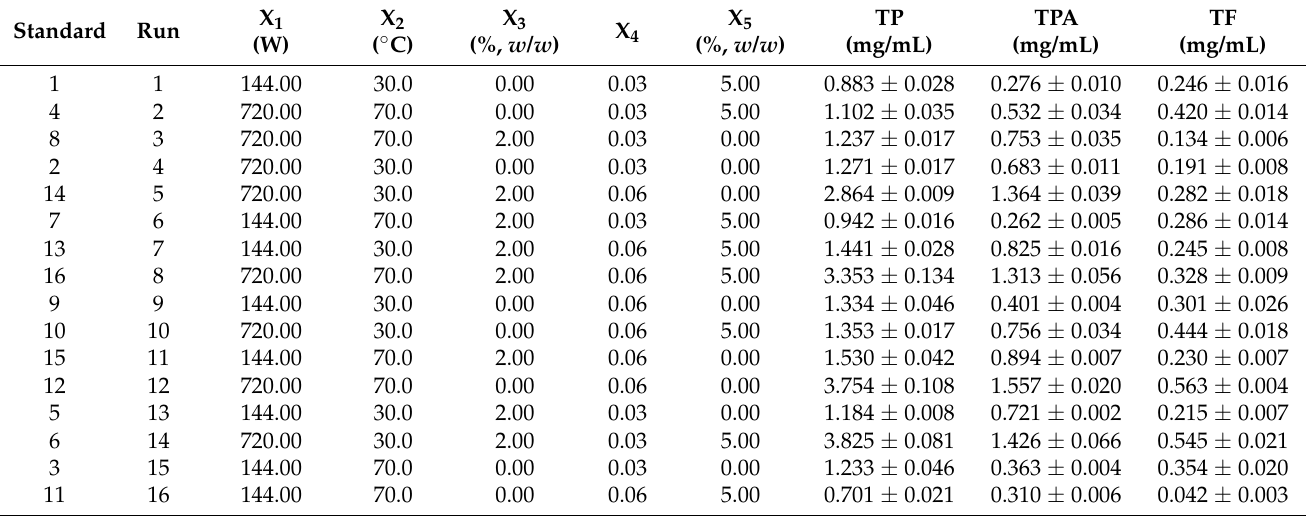
Table 2. Independent variables in the two-level factorial design and content of total phenols (TP), phenolic acids (TPA), and flavonoids (TF) in the